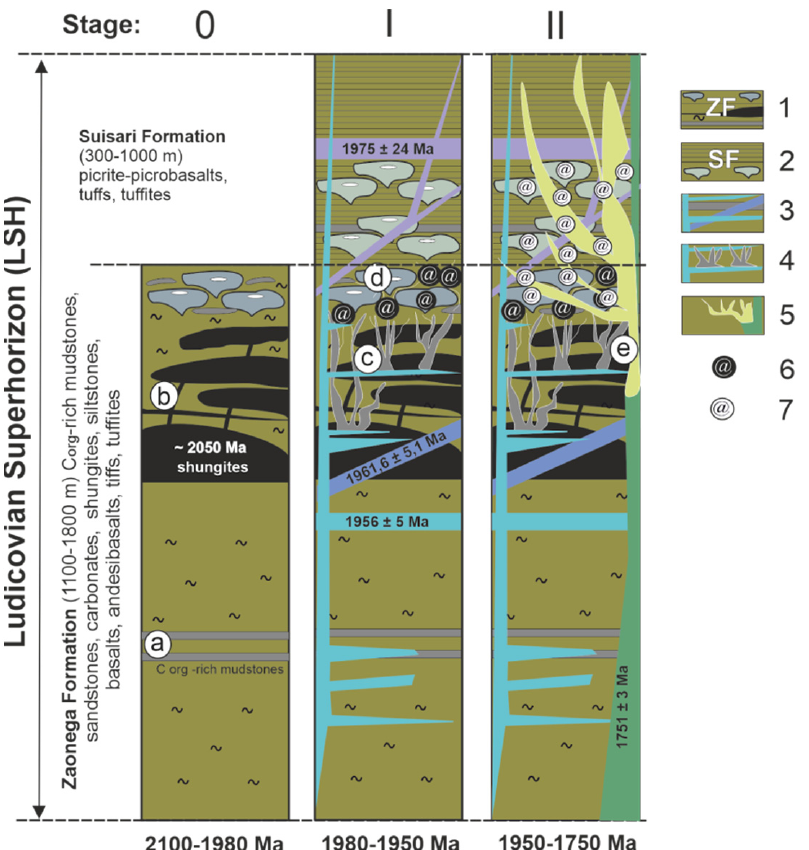
Figure 10. Schematic model of the agate formation stages in the Onega Basin. Compiled using data from [15,18,30,31,70,71]. Legend: Paleoproterozoic, Ludicovian Superhorizon ca. 2100–1920 Ma: 1—C org -rich rocks (shungites), sandstones, silt- stones, argillites, carbonates, basalts, andesibasalts, tuffs, tuffites (Zaonega Formation); 2—picrites, picritic basalts, tuffs, tuffites, tuff-conglomerates, gritstones (Suisari Formation); 3—ca. 1975–1956 Ma gabbroids; 4—ca. 1980–1950 Ma hydro- thermal fluid flow; 5—ca. 1780–1750 Ma intrusion of gabbro-dolerite sills, hydrothermal fluid flow; 6—black agates; 7— light-coloured agates. Pre-stage 0: formation of carbon-bearing mudstone ( a ) and shungite rocks ( b ) in the volcano-sedi- mentary succession of the ZF. Stage I: formation of the SF of the volcano-sedimentary succession, multiphase intrusions